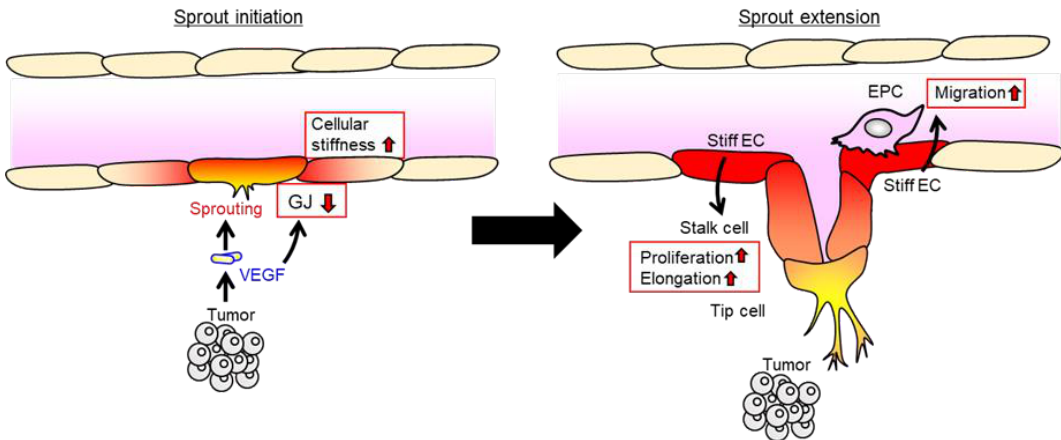
Figure 3. Potential role of endothelial cellular stiffness in cell migration. VEGF induces gap junction (GJ) reduction and the sprouting of endothelial cells may result in the stiffening of endothelial cells (ECs) during the sprout initiation phase. Stiff endothelial cells can work as a substrate for attached surrounding cells, whereas, provide a favorable environment for the recruitment of endothelial progenitor cells (EPCs), and then also support adjacent stalk cell proliferation and elongation.